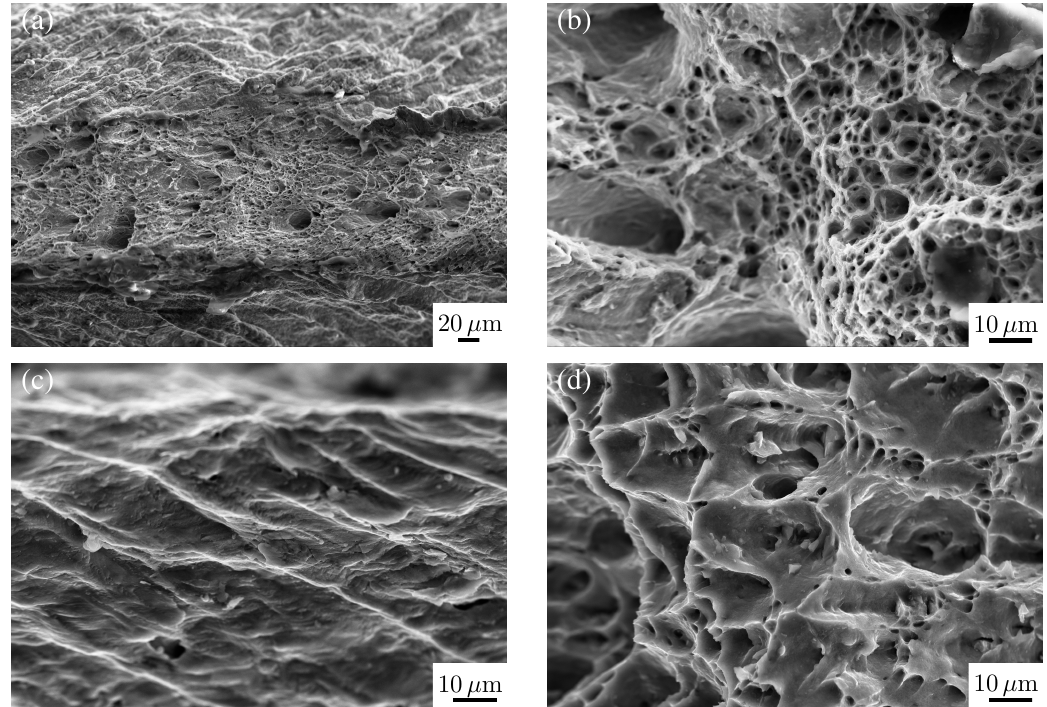
Figure 1. SEM fractograph of the top ( a , c ) and center ( b , d ) of the fracture surfaces of DC06 ( a , b ) and AA6016 ( c , d ) in uniaxial